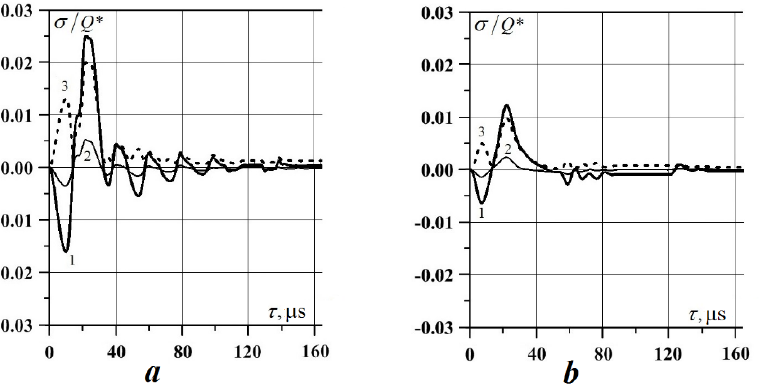
Fig. 1. Change of dimensionless radial (1), circumferential (2) stresses and von Mises stresses (3) in time τ at the front of the blast wave at distances from the center of the blast hole: a - 20 r , b - 50